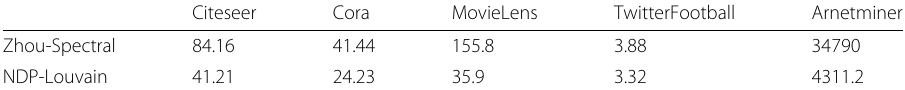
Table 4 CPU times (in seconds) for the hypergraph clustering methods on all datasets Citeseer Cora MovieLens TwitterFootball Arnetminer Zhou-Spectral 84.16 41.44 155.8 3.88 34790 NDP-Louvain 41.21 24.23 35.9 3.32